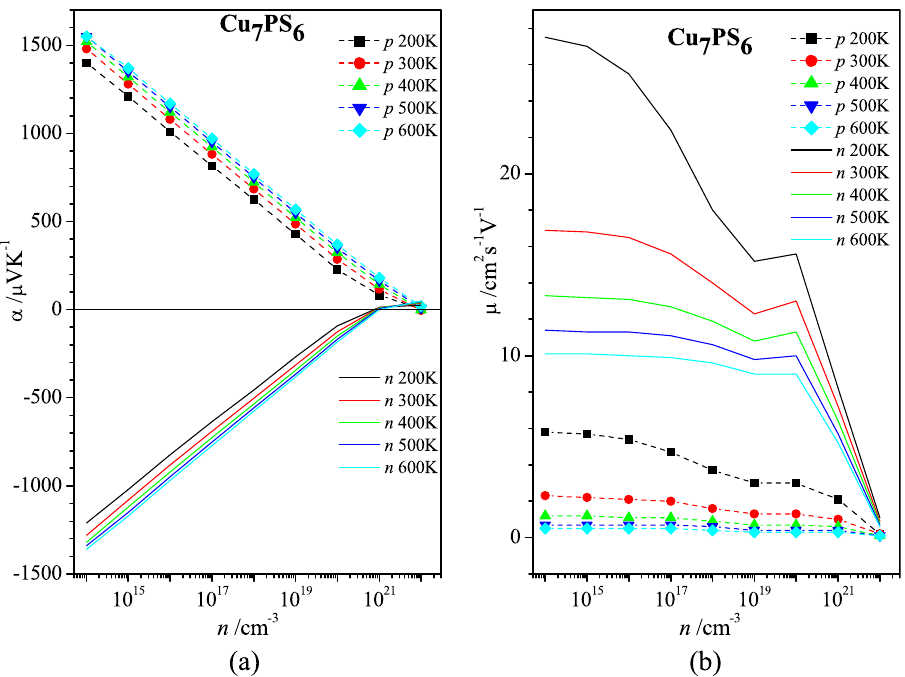
Figure 4. Dependences of ( a ) Seebeck coefficient α and ( b ) mobility μ on carrier concentration n for Cu 7 PS 6 at the temperatures 200 K, 300 K, 400 K, 500 K, and 600 K for electron ( n ) and hole ( p ) types